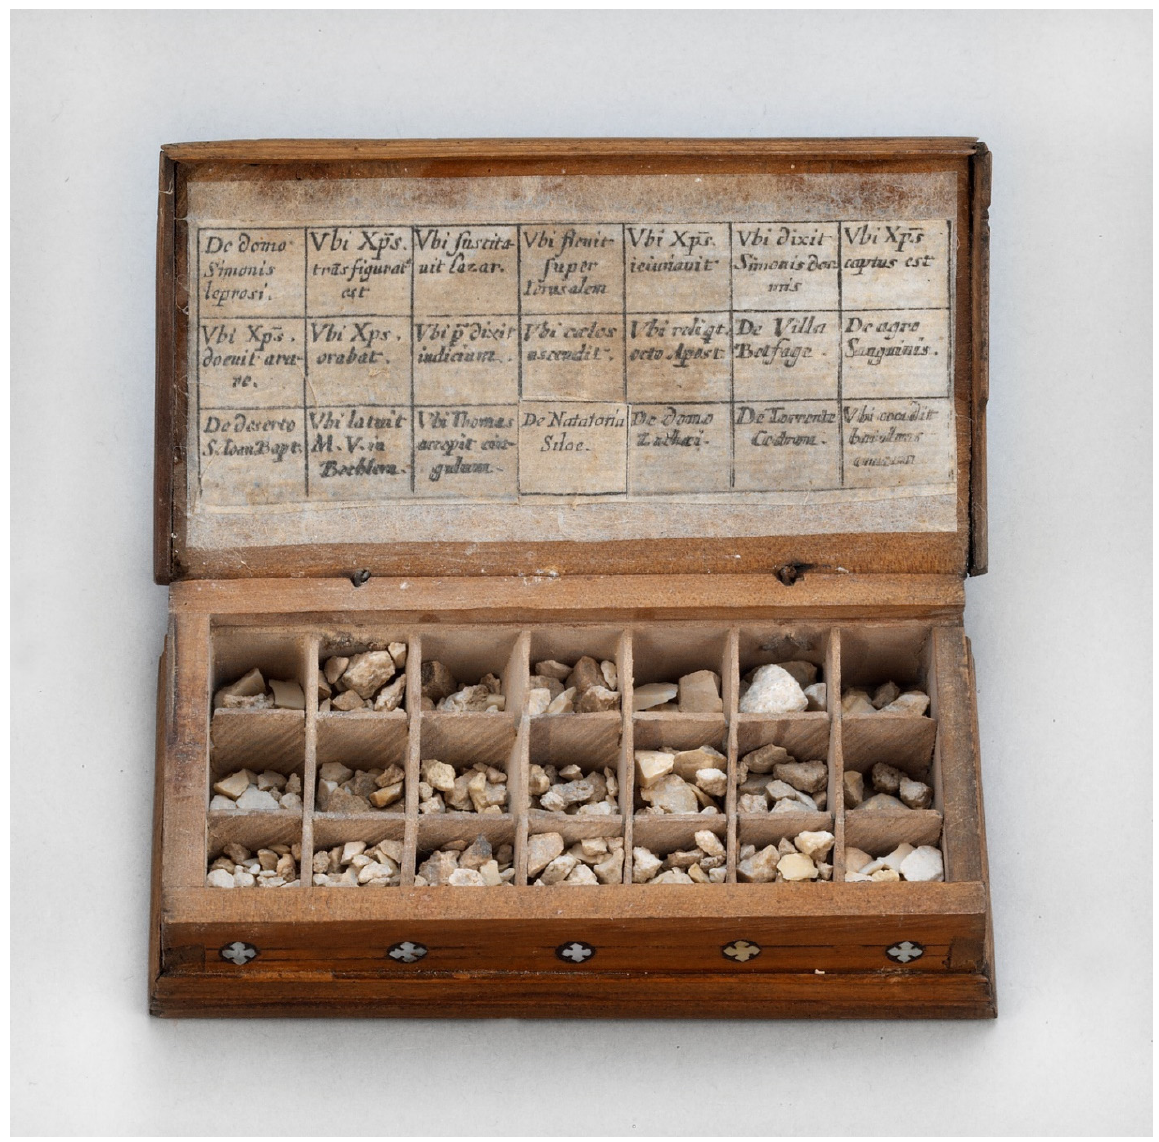
Figure 1. Seventeenth-century collection (inv.no. EFa7) of rocks from the Holy Land. Photo: The Danish National Museum in Copenhagen.